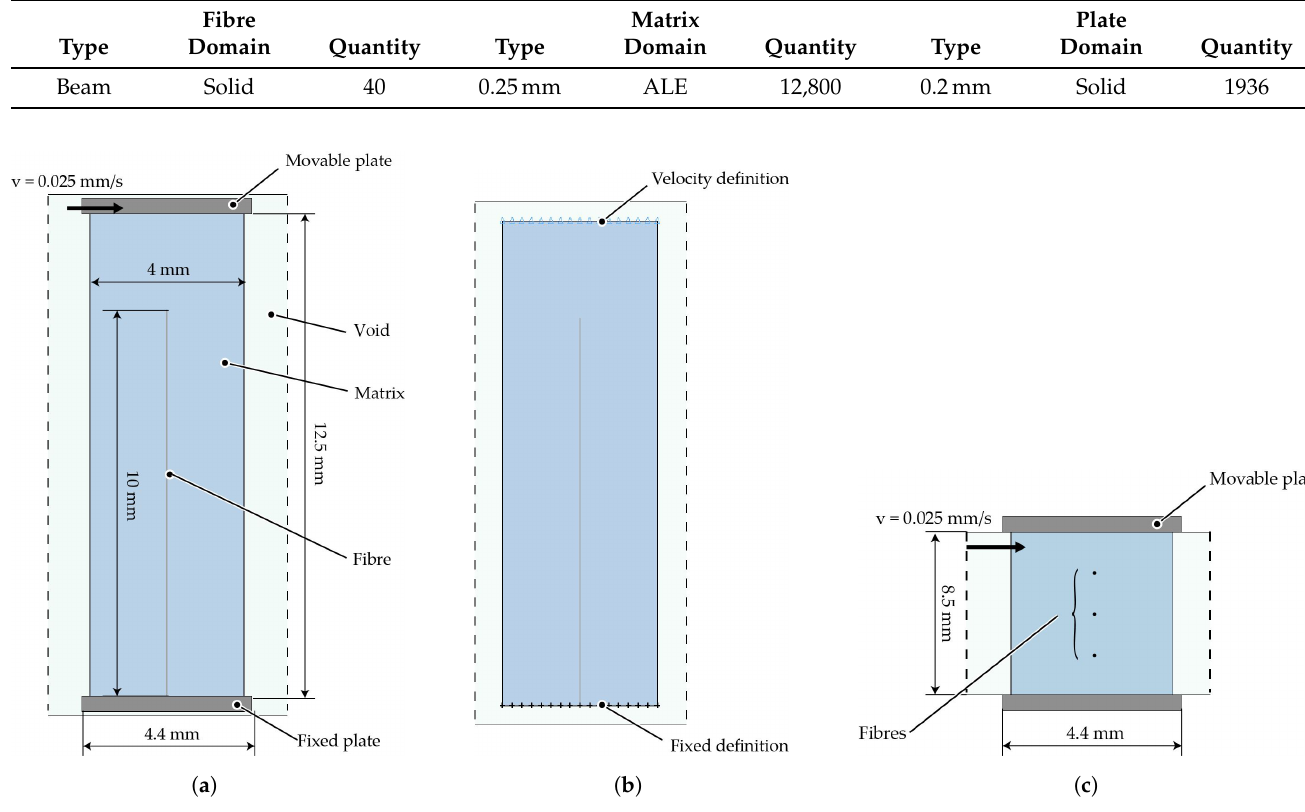
Figure 9. Simplified model of a 2D shear flow in vertical and horizontal direction with an embedded beam structure. ( a ) Vertical ALE model. ( b ) Vertical ALE model with an initial flow definition. ( c ) Horizontal ALE model.